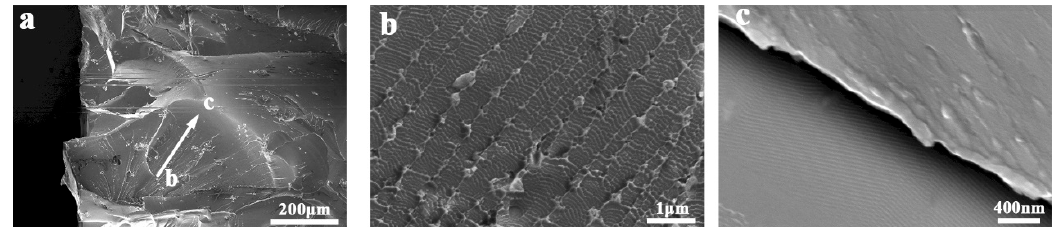
Figure 3. Fractograph of a brittle Mg 54 Cu 28 Ag 7 Y 11 MG with many periodic nanoscale wavy corrugations. ( a ) The overall appearance of the conchoidal fractograph. ( b ) Enlarged image of wavy corrugations on the conchoidal fractograph. ( c ) Enlarged image of nanoscale wavy corrugations at the edge of the conchoidal